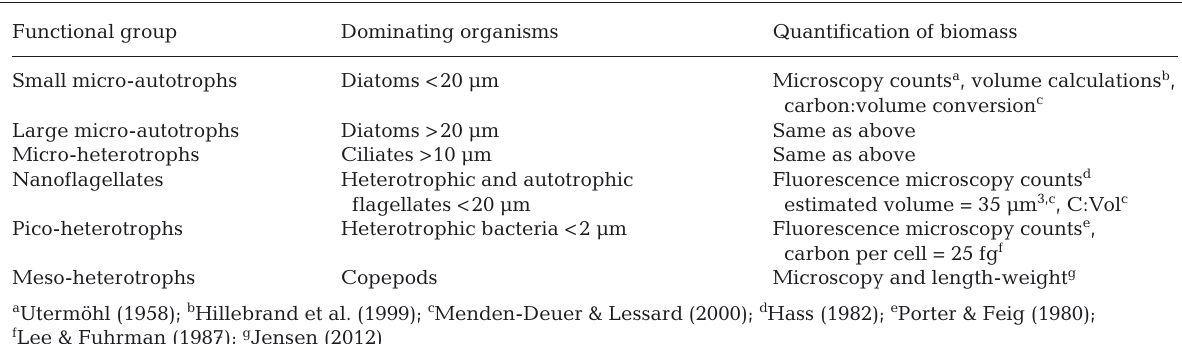
Table 2. Functional groups in the microbial food web, dominating organisms in each group, and methods used to quantify the organisms and to estimate the carbon